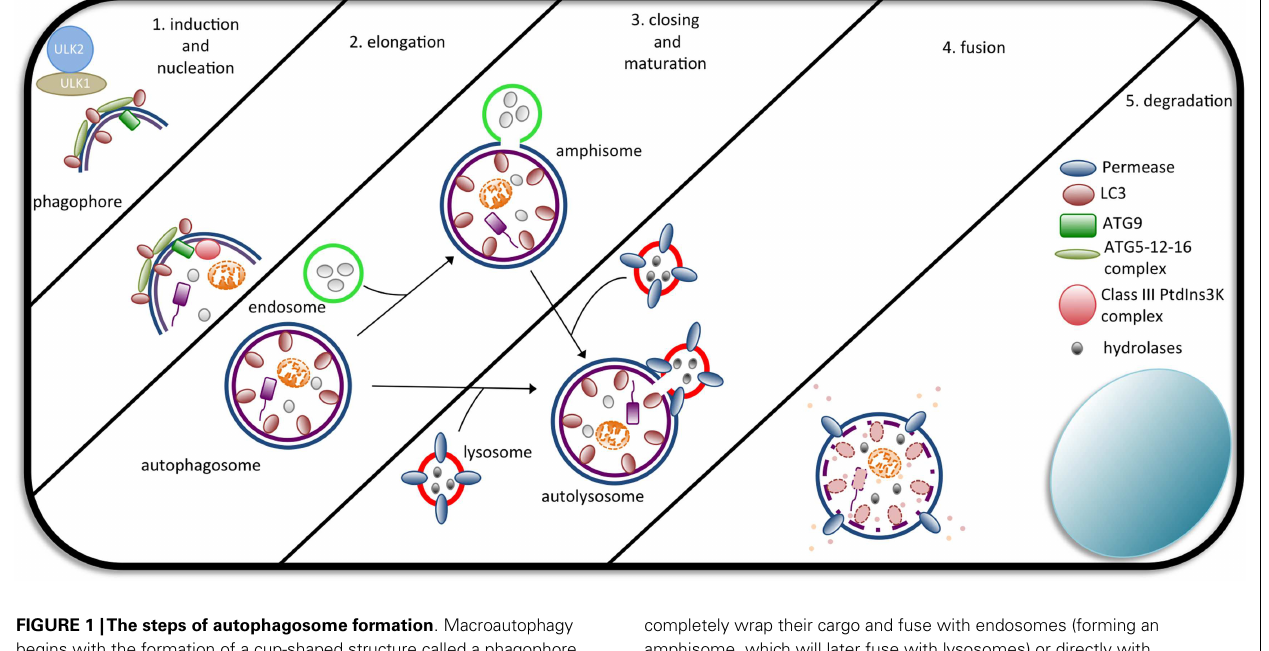
completely wrap their cargo and fuse with endosomes (forming an amphisome, which will later fuse with lysosomes) or directly with lysosomes, forming an autolysosome. Upon fusion, the cargo is degraded by lysosomal hydrolases and exported back to the cytosol to be used by the